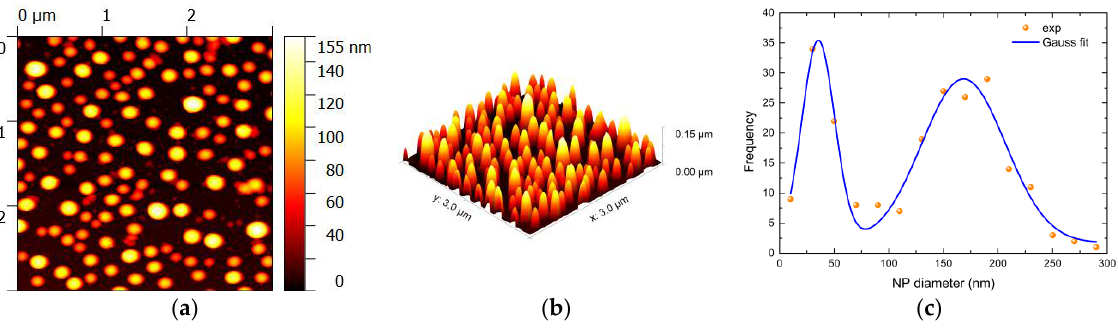
Figure 10. ( a ) Two- and ( b ) three-dimensional AFM images and nanoparticle size distribution dia- gram ( c ) for the area of the Ag #1 (13.5 nm) film irradiated at a frequency of 50 kHz with a 0.05 mm fill spacing.